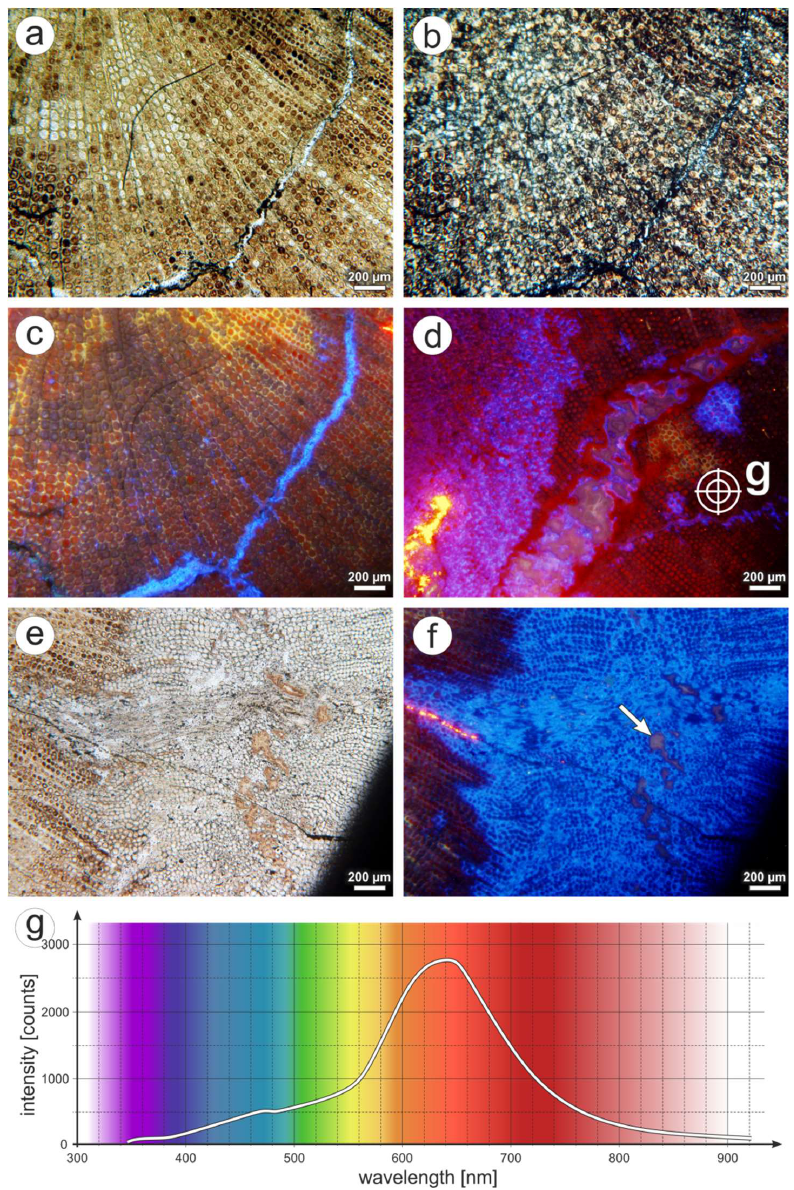
Figure 9. CL of K6556. ( a ) Anatomically well-preserved wood of the inner part of the root (type 1; PPL image). ( b ) Same view as in (a); XPL image. ( c ) CL image of (a). Note limitation of yellow CL to the former cell walls, whereas red CL occurs within the cells. Fracture filling shows a short-lived blue CL. ( d ) All CL spectra detected in K6556; image taken from the inner root. Note that anatomical preservation within irregularly shaped occurrences of short-lived blue CL is lower than around. ( e ) Anatomically poor-preserved wood of the outer rim of the root (type 2; PPL). ( f ) CL image of (e). Brown-luminescing agate fills holes in the wood (arrow). The occurrence of short-lived blue CL is strictly connected to cellular preservation. ( g ) CL spectrum taken at